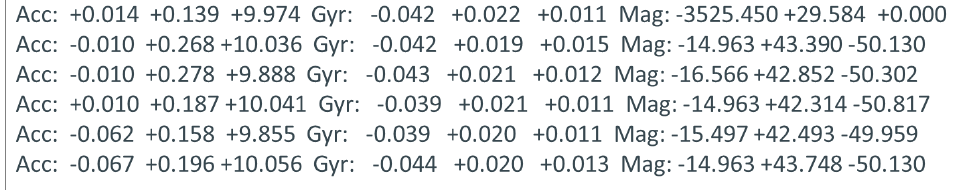
Figure 11. Results of the IMU test. Acc: linear accelerations on the x, y, and z axes, respectively. Gyr: the angular velocities respectively around the x, y, and z axes. Mag: data provided by the magne- tometer indicating the orientation of the